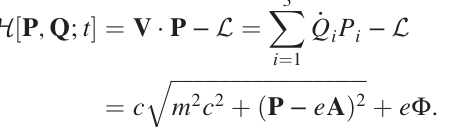
FIG. 5. Schematic plot of a reference orbit for an accelerator consisting of five straight and five 72° curved sections. Lab frame and local Frenet-Serret frames are shown in black and blue colors respectively. The test particle winding the equilibrium orbit is shown in red.